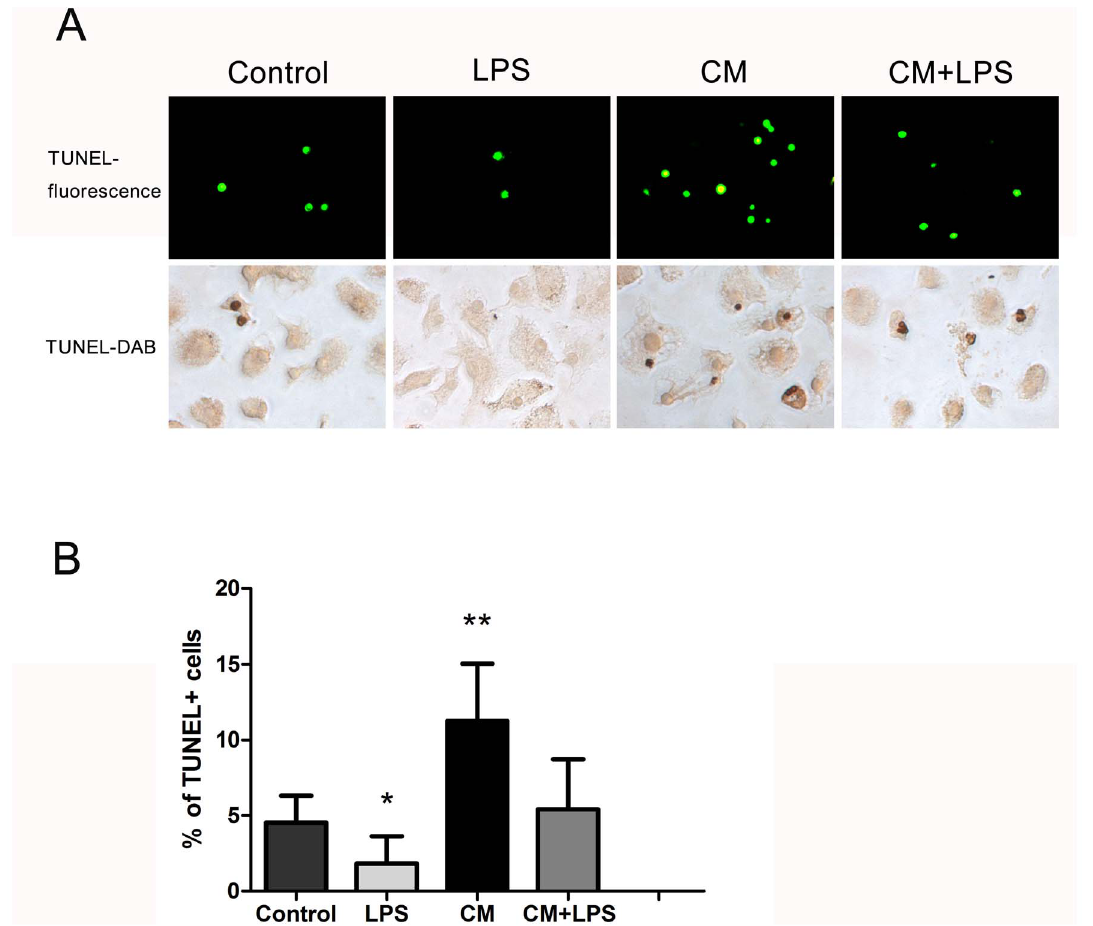
Figure 6. BMSC-induced apoptosis of microglial cells. We investigated the effects of conditioned medium on apoptosis of microglial cells by TUNEL assay. (A) Cells were observed under a fluorescence microscope (magnification 400 6 ), or stained with DAB and observed under an optical microscope (magnification 400 6 ). We found fewer apoptotic cells in the LPS-treated groups compared with the control groups, while apoptosis was increased in the groups cultured in BMSC-CM. (B) The percentage of apoptotic microglial cells among the total number of microglial cells in each group is shown. Bars represent means plus or minus SD obtained from eight random fields. *P , 0.05, **P , 0.01, compared with control groups.